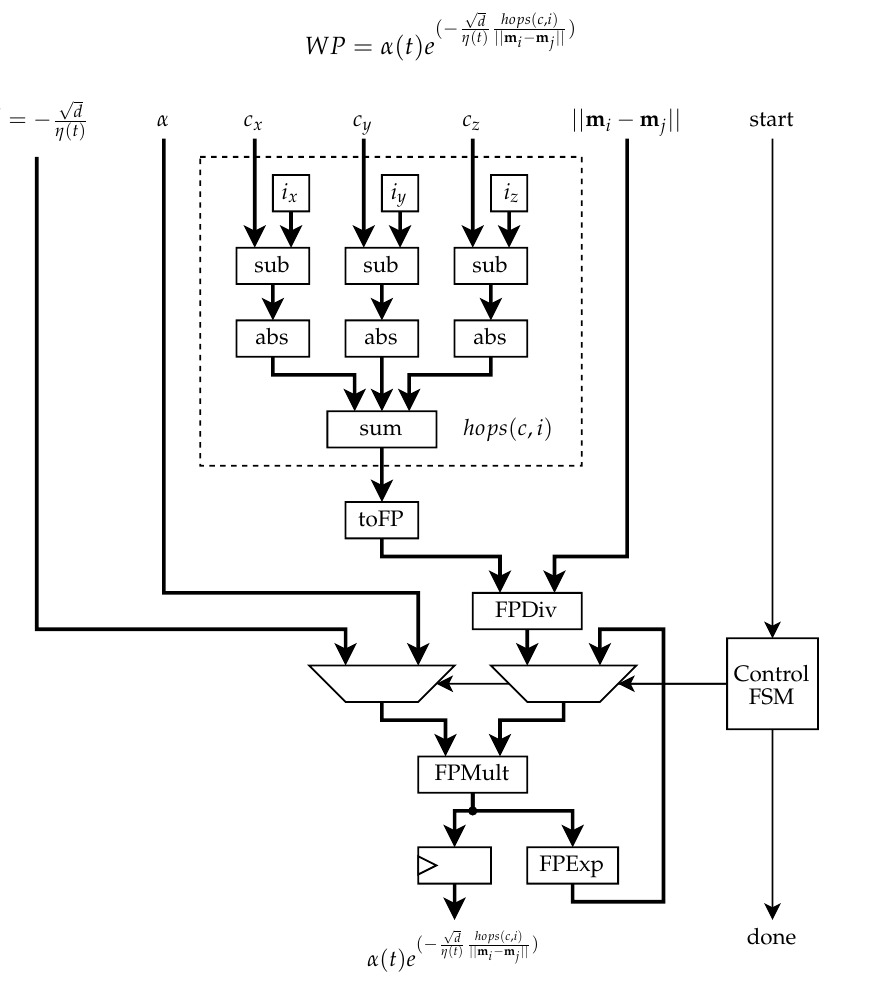
Figure 12. Weight update coefficient